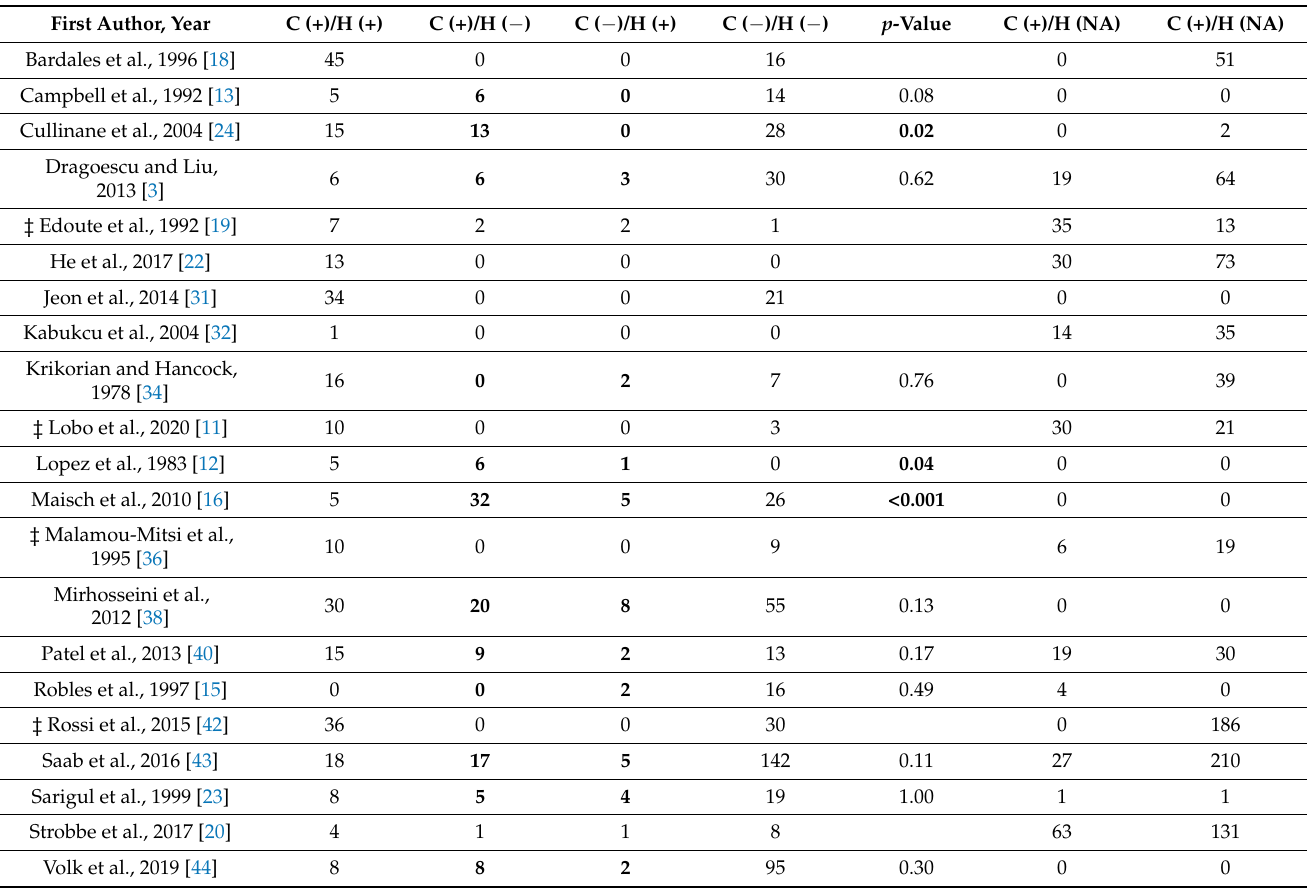
Table 3. Comparison of cytology and histology for detecting cancer in pericardial effusions. The studies showing differences in their cytology vs. histology findings are compared, and the resulting p -values are shown in the Table. Results exhibiting differences between cytology and histology, also p -values < 0.05, are highlighted with Bold